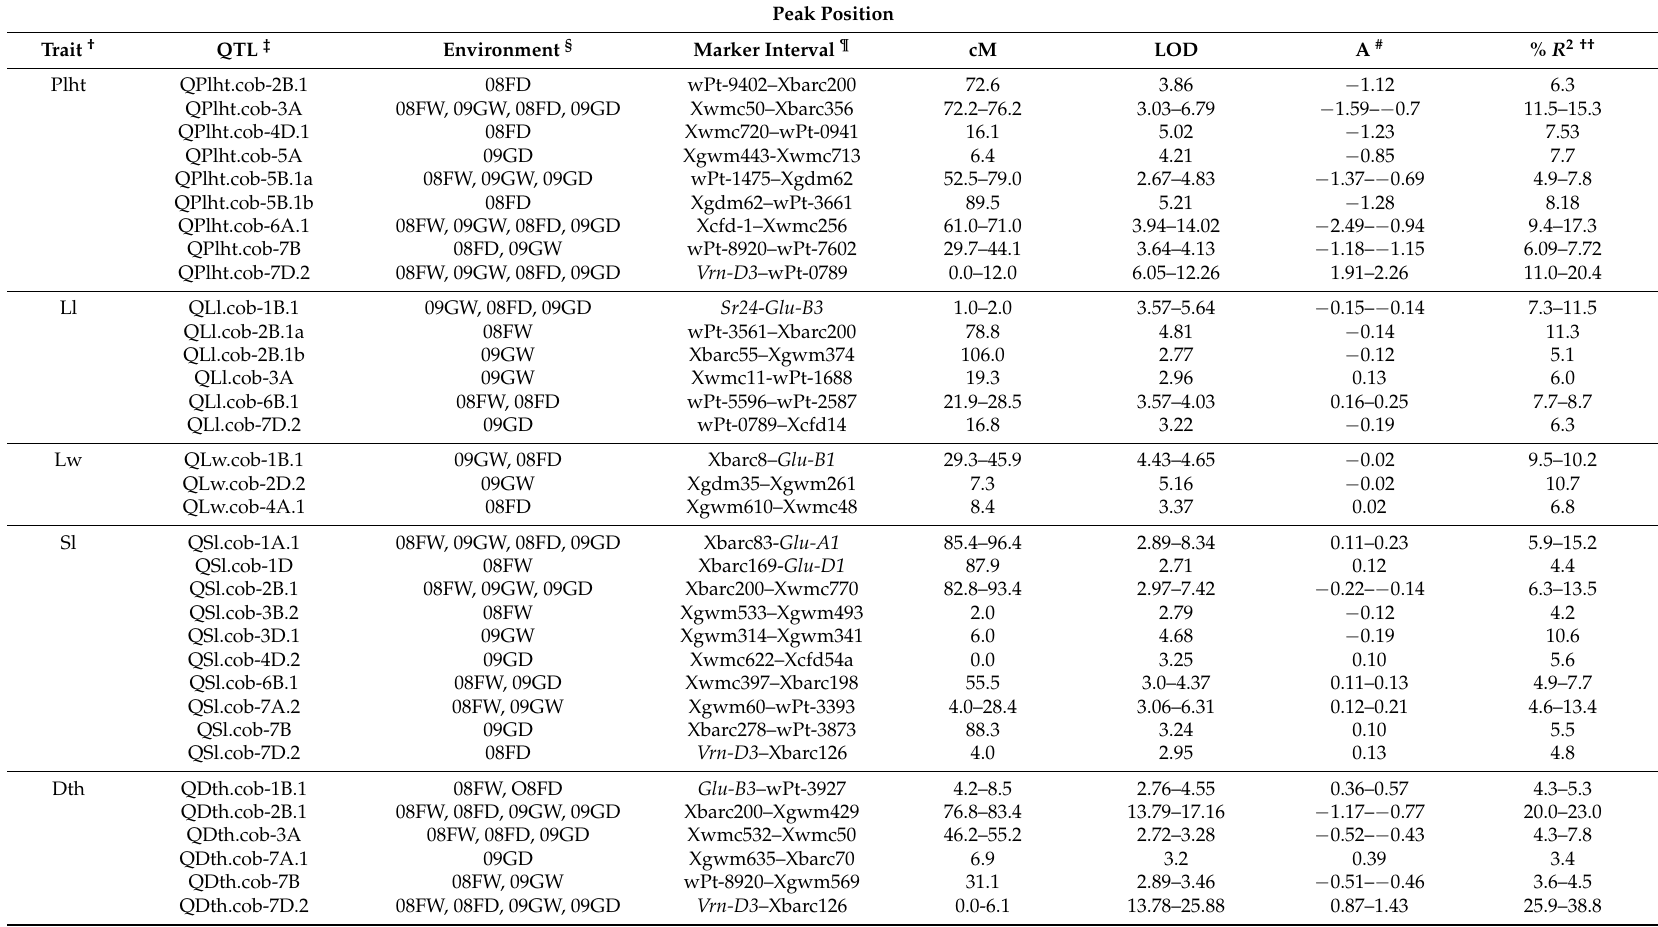
Table 2. QTL detected for agronomic traits of the CO940610/Platte population in four Colorado environments in the 2007–2008 and 2008–2009 growing seasons. Peak